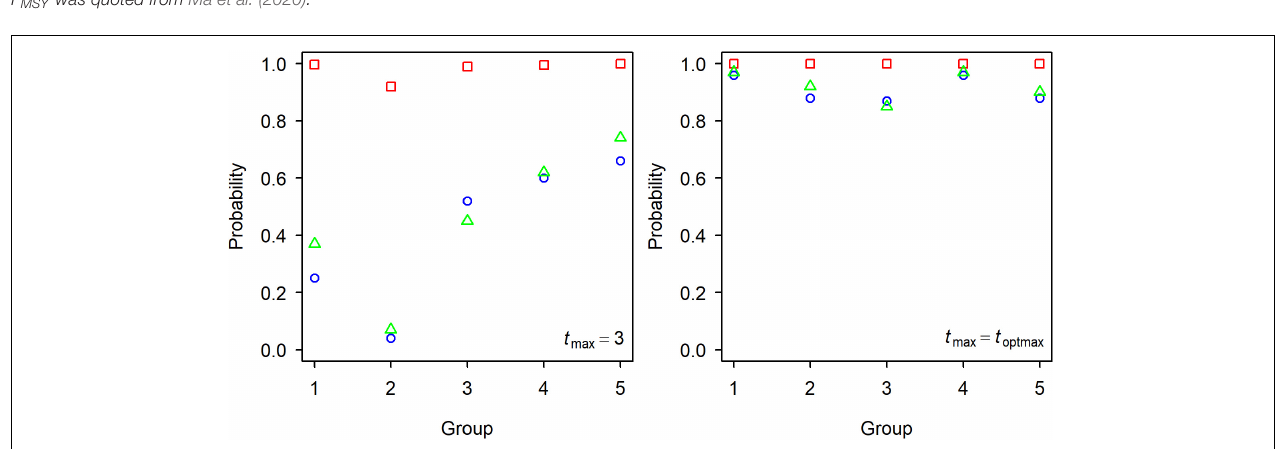
FIGURE 4 | The probability of F cur being greater than the biological reference points F max (green triangle), F 0 . 1 (red square), and F 20% (blue circle) for each group of small yellow croakers.